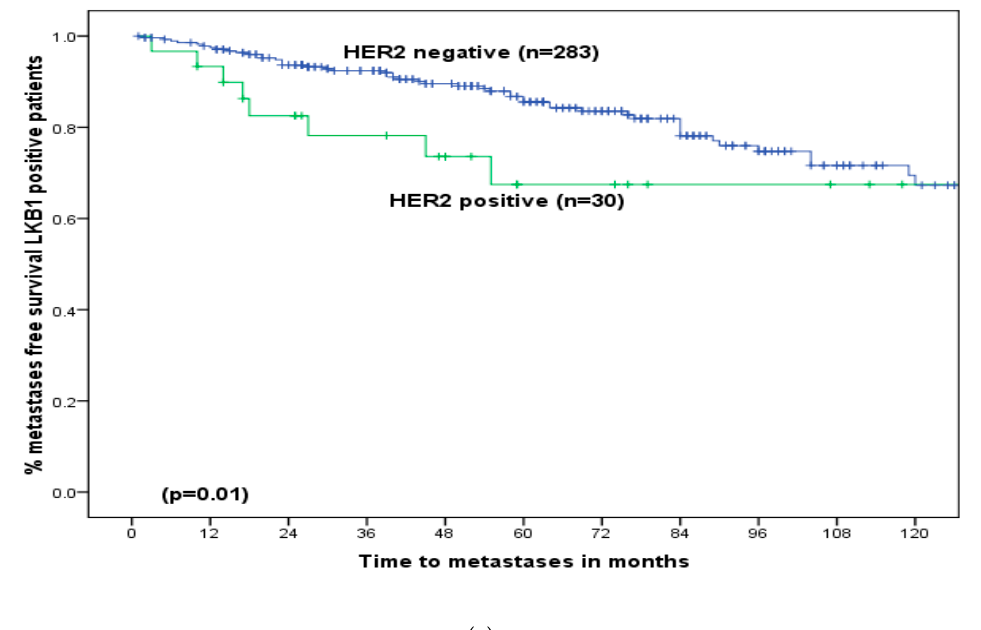
Figure 5. ( a ) Metastasis-free survival in LKB1 positive early operable primary breast cancer in older women: ER positive versus ER negative. ( b ) Metastasis-free survival in LKB1 positive early operable primary breast cancer in older women: PgR positive versus PgR negative. ( c ) Metastasis-free survival in LKB1 positive early operable primary breast cancer in older women: MUC1 positive versus MUC1 negative. ( d ) Metastasis-free survival in LKB1 positive early operable primary breast cancer in older women: Bcl2 positive versus Bcl2 negative. ( e ) Metastasis-free survival in LKB1 positive early operable primary breast cancer in older women: HER2 positive versus HER2 negative.